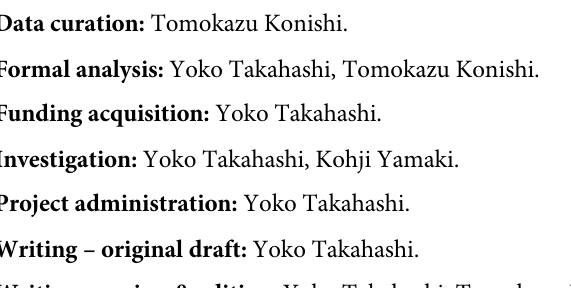
S7 Table. A list of differentially expressed probe sets involved in the PC2